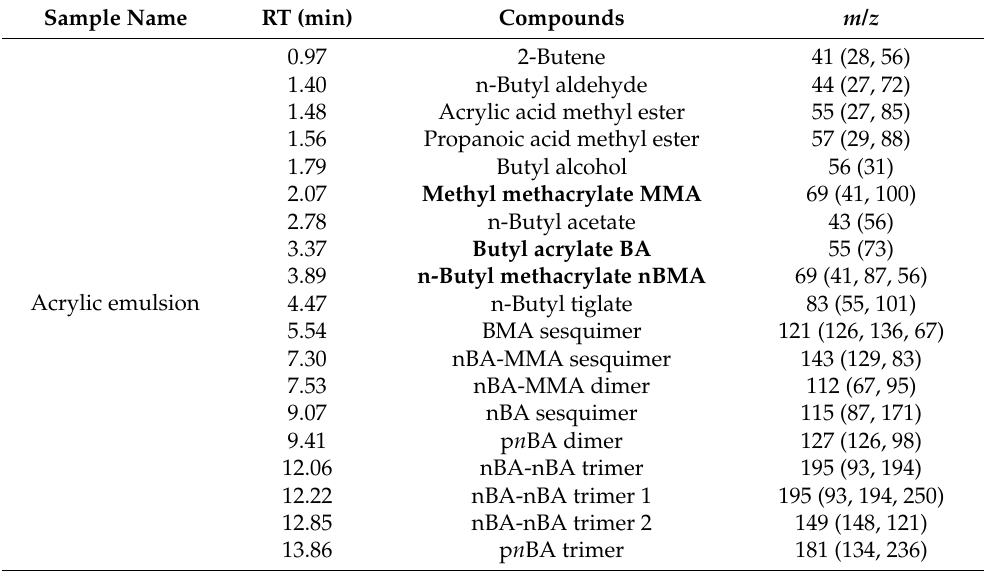
Table 3. Compounds identified in unaged pure acrylic emulsion by Py-GC/MS analysis. The most intense peaks were listed in